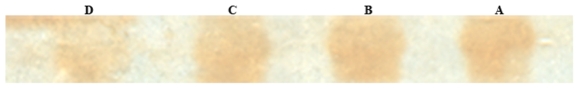
Western-Blotting analysis of the amont of β-casein.A: mammary gland; B: epithelial cells cultured in inducentment meida; C: resuscitated epithelial cells cultured in inducement meida; D: epithelial cells cultured in growth meida.